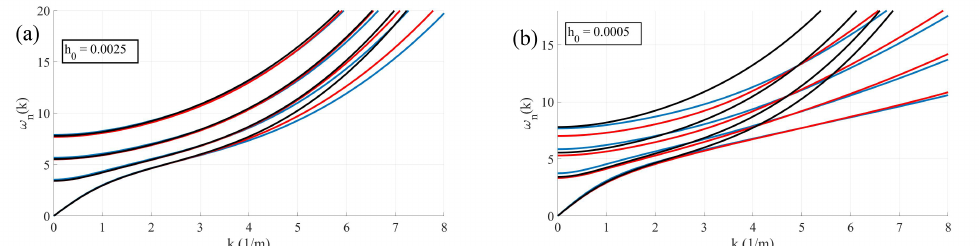
Figure 3. Dispersion relations for the first four hydroelastic modes. Black lines show results for the ice with constant thickness h ∗ = 0.0035 m, blue lines—Case 1, red lines—Case 2. ( a )— h 0 = 0.0025 m, ( b )— h 0 = 0.0005